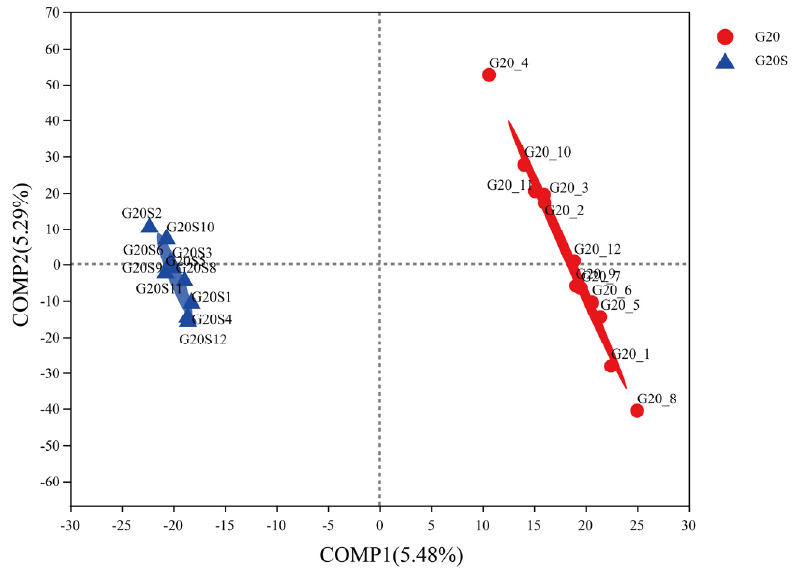
Figure 3. Differences in bacterial community structure between the G20 (noninoculation) and G20S (strain SR-9 inoculation) treatments based on PLS-DA.